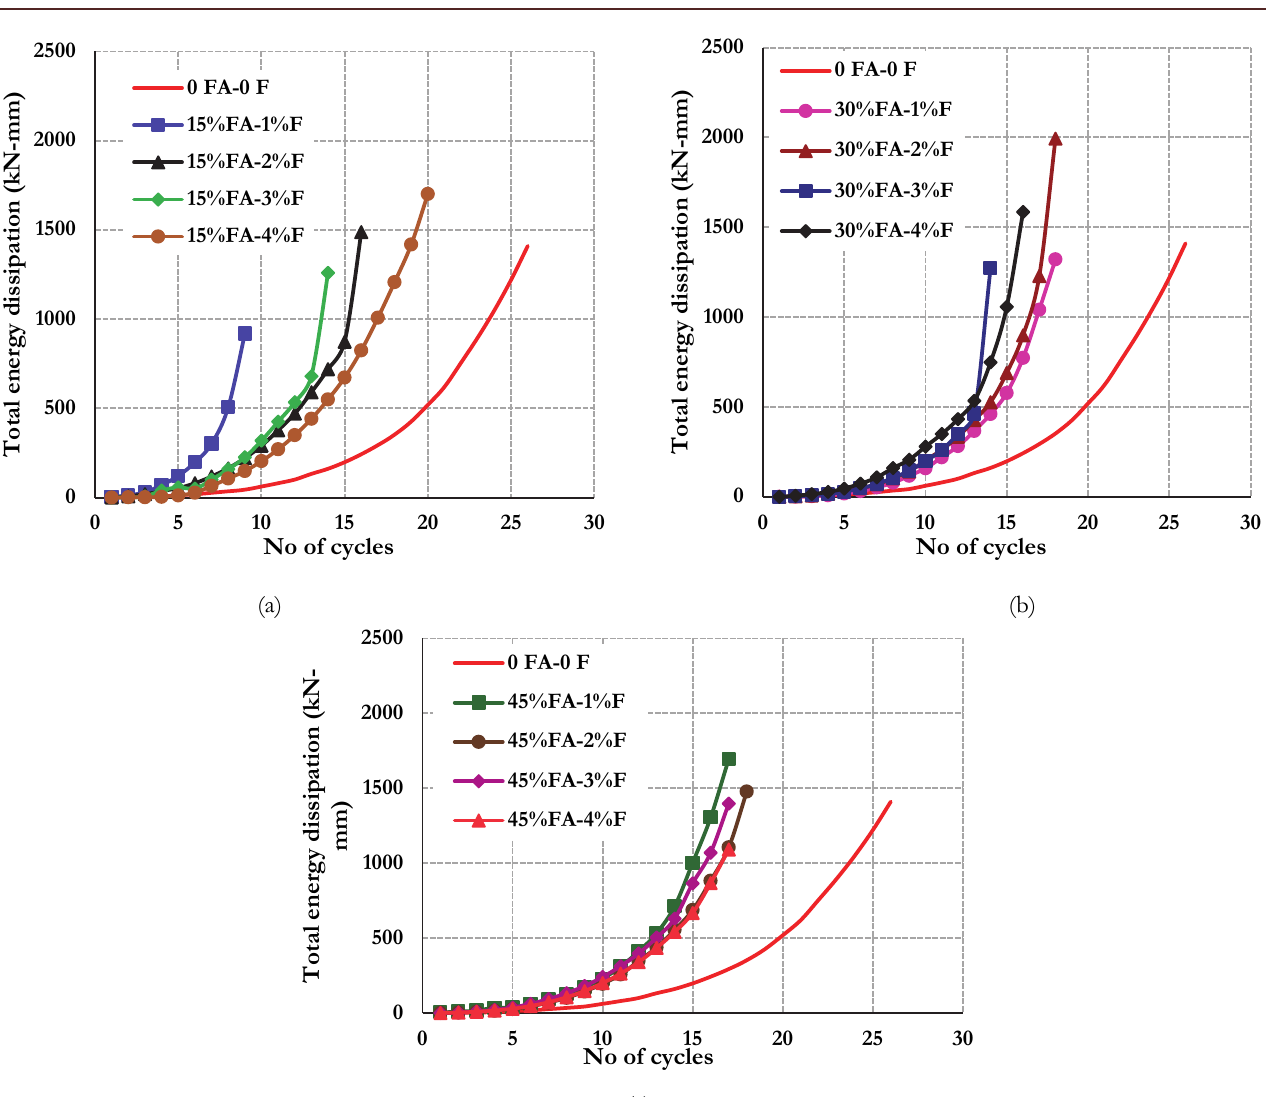
Figure 12: Total energy dissipation for all beams :(a)group1, (b)group2, and (c)group3.